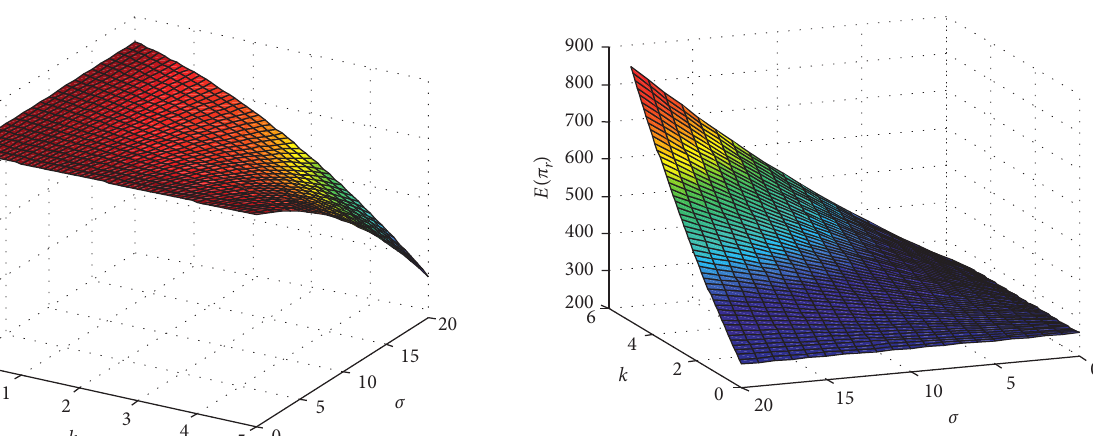
Figure 6: The trend of the retailer’s profits under the retailer- dominant structure.